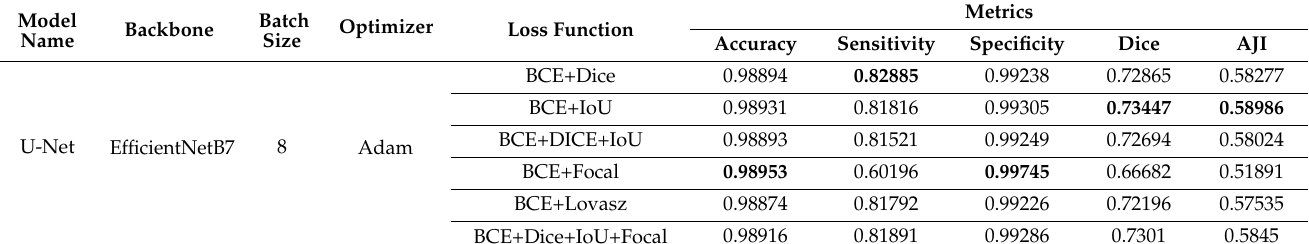
Table 3. Comparative results of U-Net with different loss functions (bold represents the best performance).